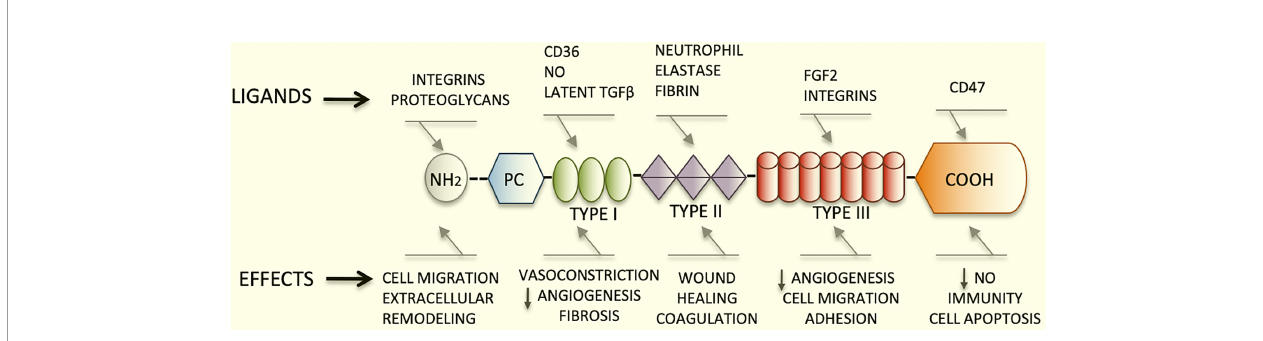
FIGURE 1 | Schematic diagram representing the structure of TSP1, its major ligands and functions. TSP1 displays an amino terminus that interacts with integrins and proteoglycans. The type I, II, and III repeats and the carboxyl-terminal end are also represented herein. The type I repeats also named TSRs contain the binding domain for CD36, responsible for endothelial apoptosis. The sequence RFK that activates the latent form of transforming growth factor beta1(TGF b 1) is also found within these repeats. The type III repeats of TSP1 contain domains that interact with neutrophil elastase and inhibit FGF2. Finally, the carboxyl-terminal domain of TSP1 binds to CD47. This domain interacts with integrins modulating cell adhesion, spreading and migration. TSP1 binds to a diversity of relevant proteins and growth factors not shown in this fi gure in lieu of